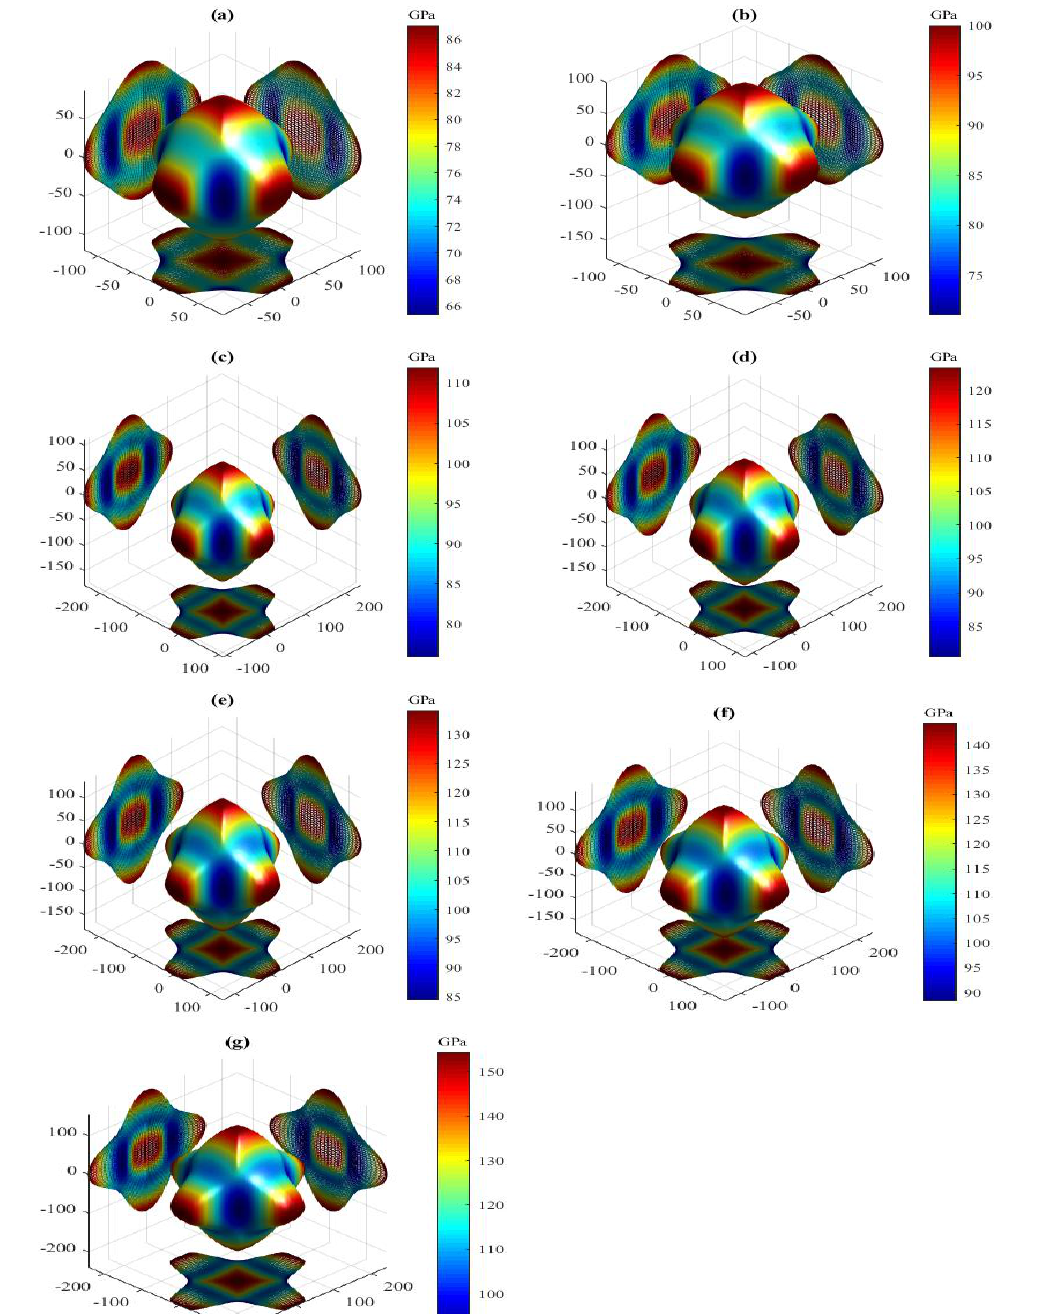
Figure 9. Directional dependence of shear modulus for the LPS r-Al 2 Ti under pressure ( a ) 0